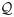
Complete map for the trajectory planning problem.The agent must attain the target set Q while avoiding obstacles.